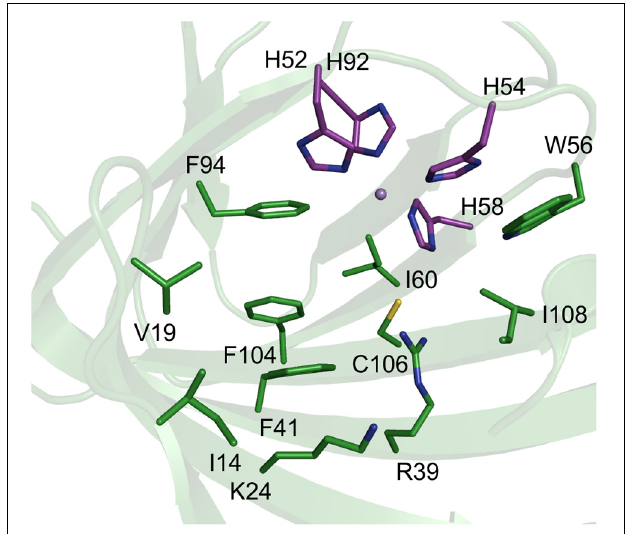
FIGURE 1 | Active site amino acids depicted as sticks in a cartoon presentation of the structure of TM1459 (pdb-code: 1VJ2, Jaroszewski et al., 2004). Metal-binding residues are displayed in magenta. The figure was prepared using the program PyMOL.